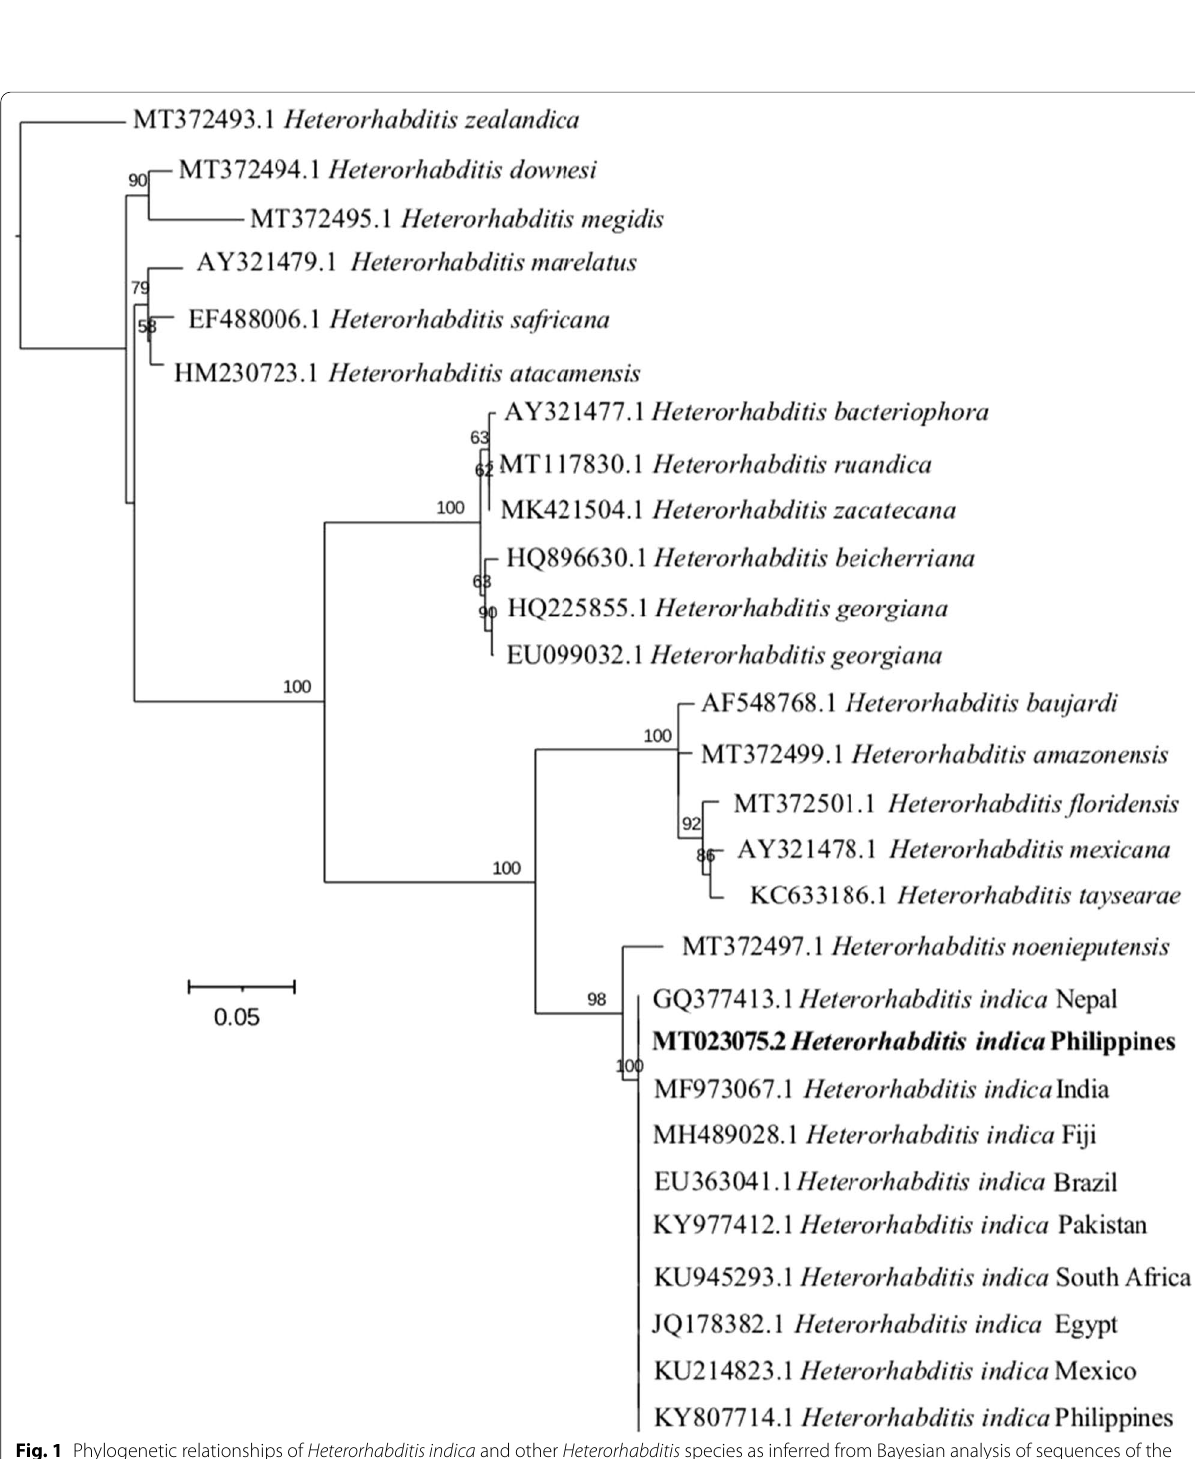
Fig. 1 Phylogenetic relationships of Heterorhabditis indica and other Heterorhabditis species as inferred from Bayesian analysis of sequences of the Internal Transcribed Spacer (ITS1-5.8S-ITS2) rDNA region. Bayesian posterior probabilities (%) equal to or more than 60% are given for appropriate clades. The scale bar shows the number of substitutions per